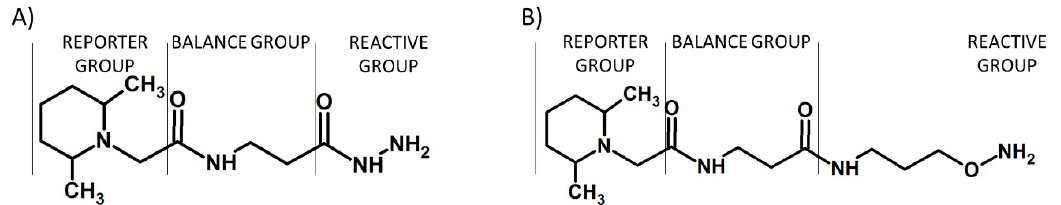
Figure 9. Schematic presentation of the glyco-TMT reagents containing hydrazide ( A ) or aminoxy carbonyl-reactive groups ( B ) [13].